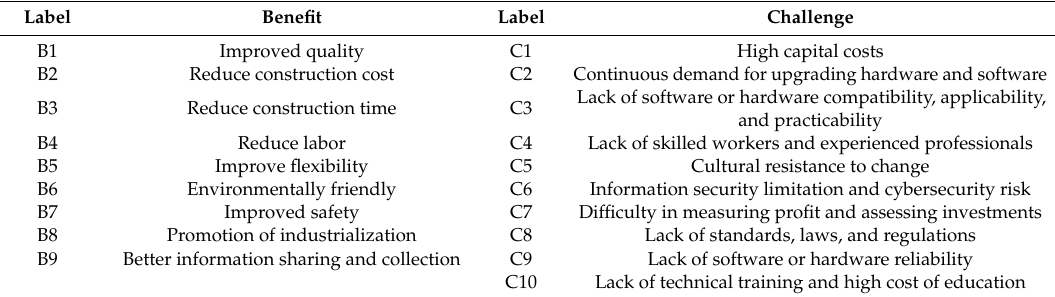
Table 2. List of benefit and challenge